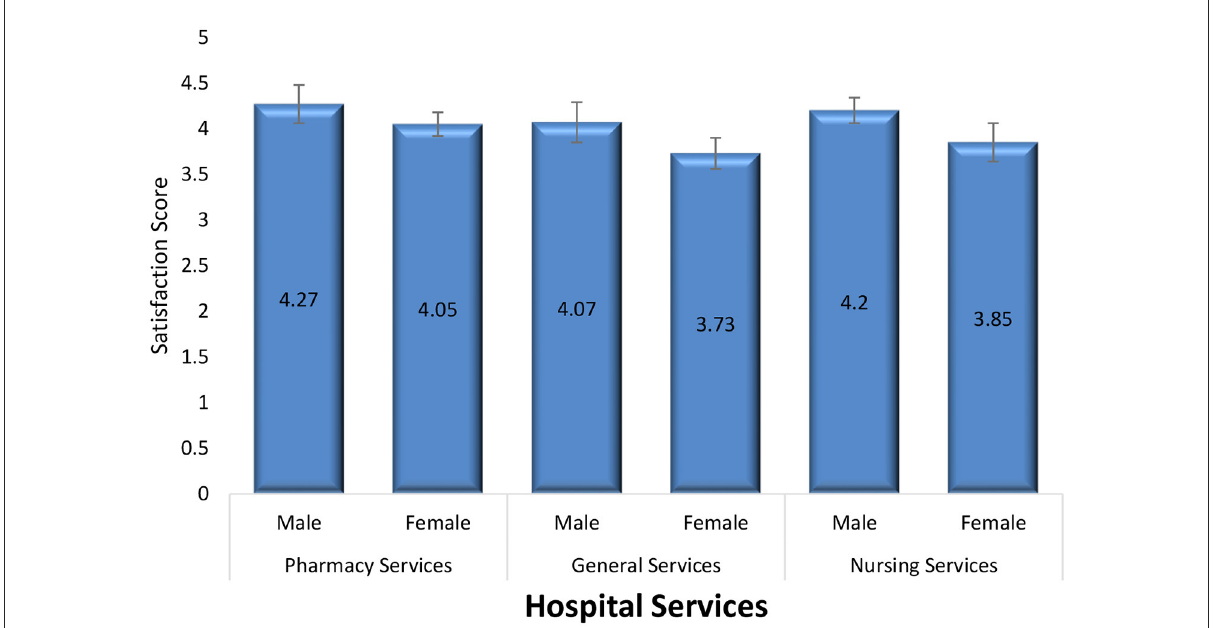
FIGURE1 Comparison of satisfaction of pharmacy services with other hospital